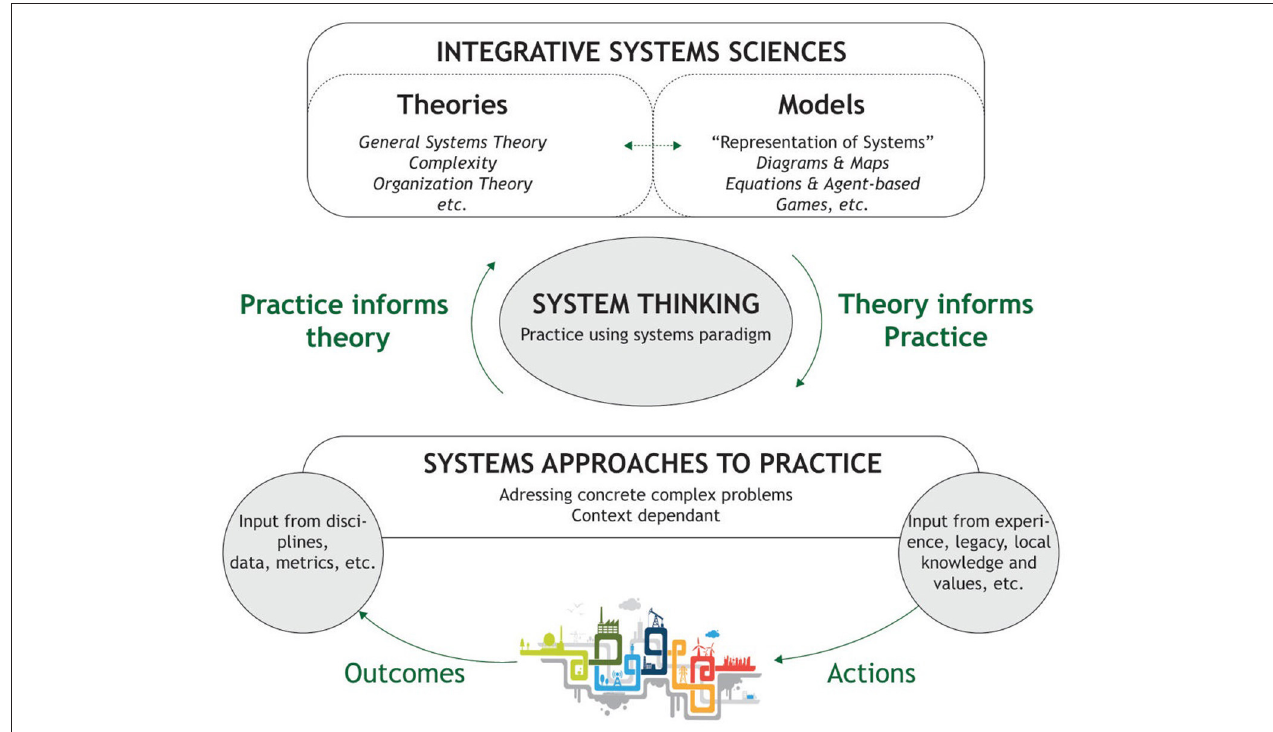
FIGURE 1 | Systems thinking—Adapted from